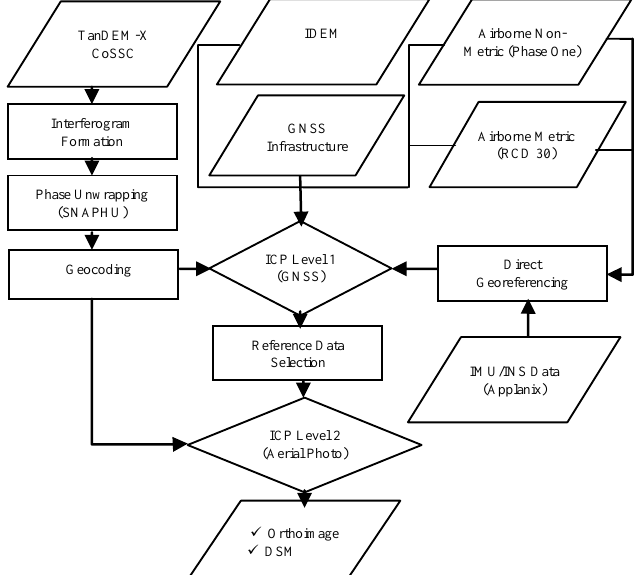
Figure 1. Workflow of our